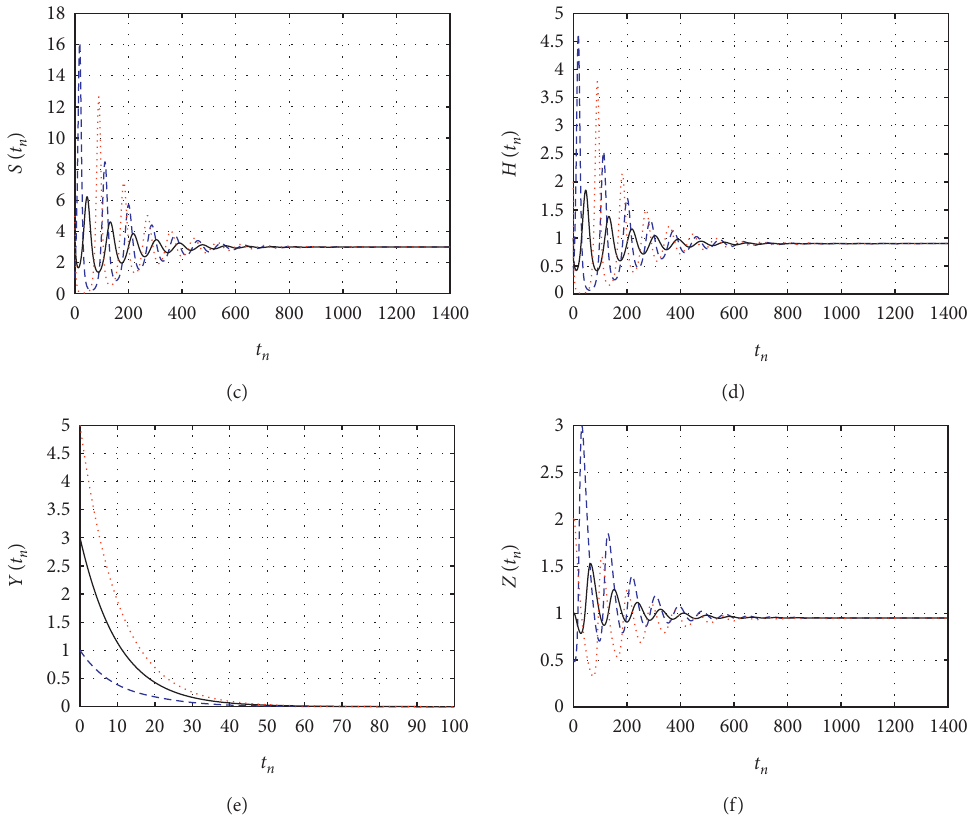
Figure 4: The solutions of systems (12)–(17) for case R Z